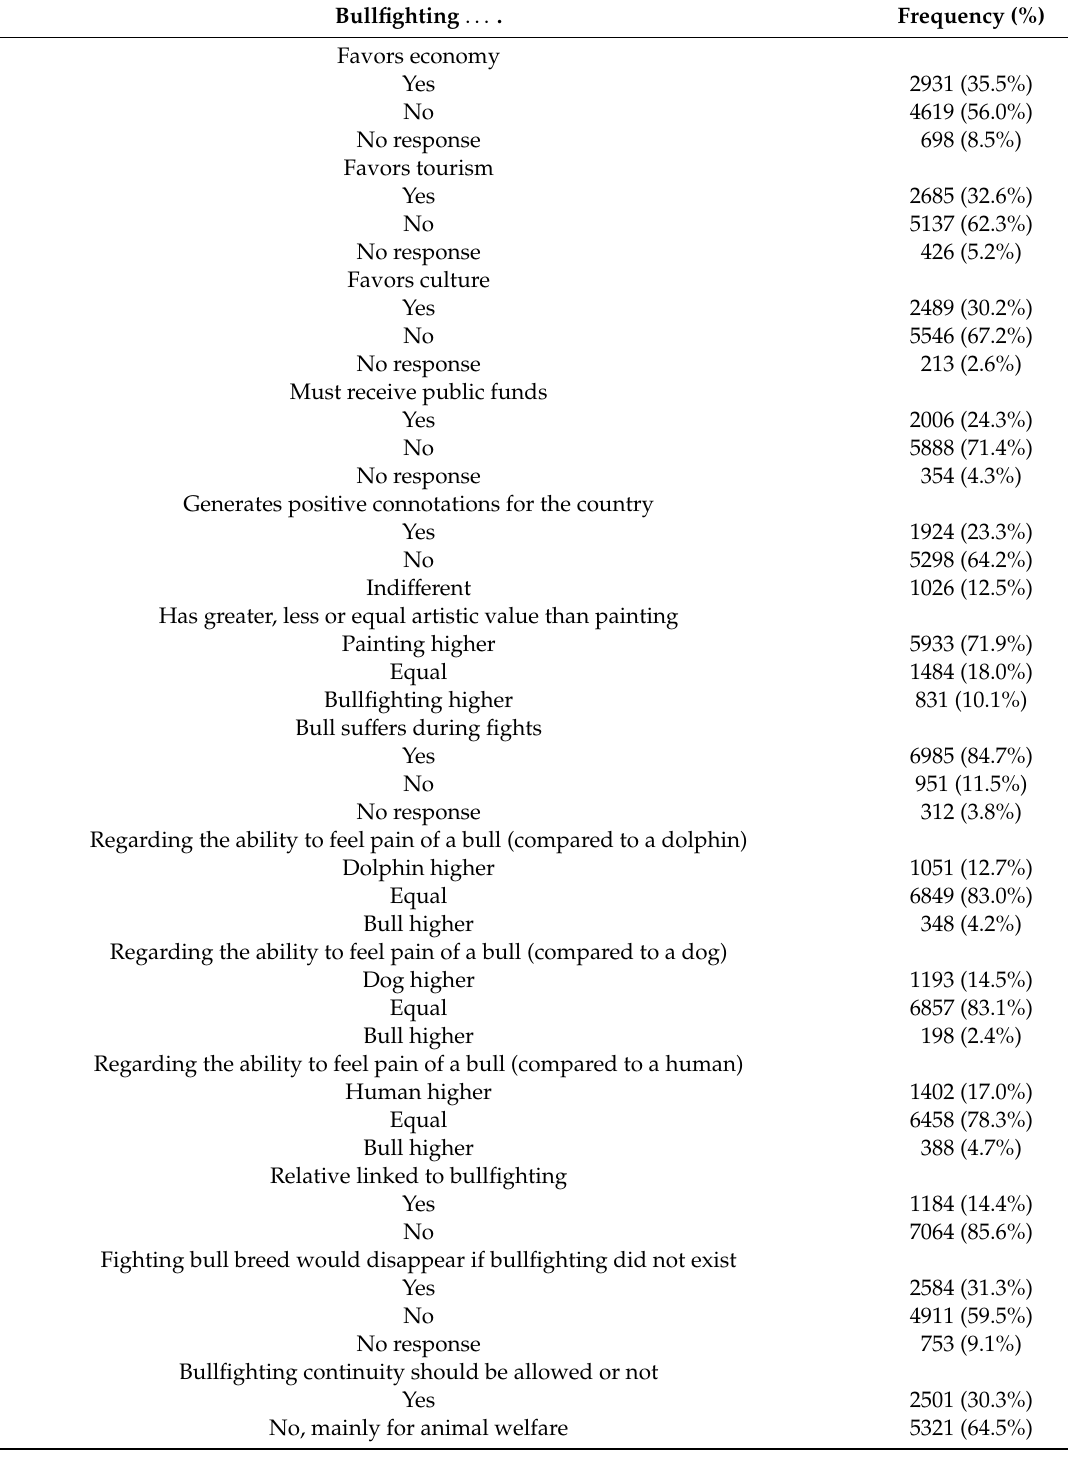
Table 4. Summary of respondents’ opinions regarding bullfighting (N = 8248 individuals). Bullfighting ...